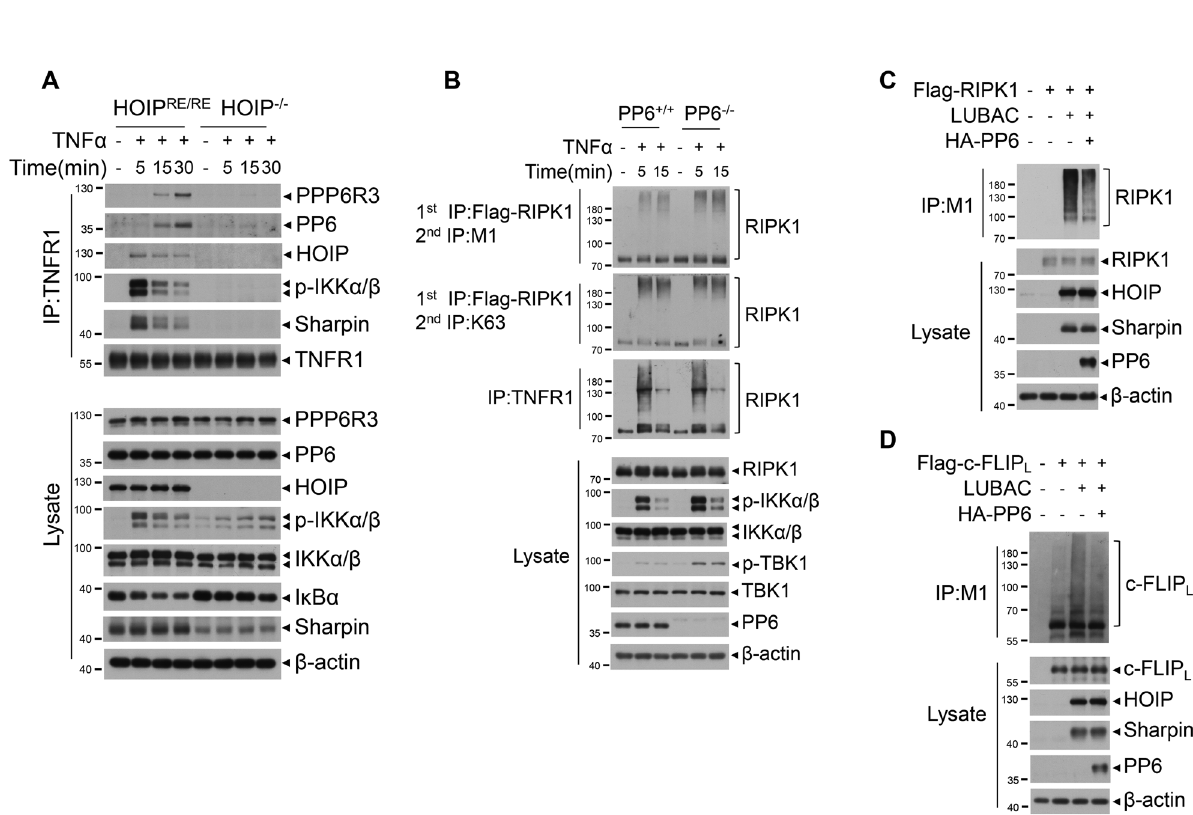
Fig. 6 PP6 negatively modulates LUBAC-mediated M1-ubiquitination of RIPK1 and c-FLIP L . A HOIP − / − or HOIP reconstituted MEFs were treated with TNF α for indicated periods time. Cells were lysed with NP-40 buffer and immunoprecipitated with anti-TNFR1 antibody. The immunocomplexes and whole-cell lysates were analyzed by western blotting with indicated antibodies. B PP6 + / + and PP6 − / − L929 cells with Flag-RIPK1 stable expression were treated with TNF α for indicated periods of time. Cells were lysed with NP-40 buffer and immunoprecipitated with anti-Flag beads. The isolated complex I was eluted with urea lysis buffer. The eluted complex I was further immunoprecipitated with chain speci fi c M1 or K63 ubiquitin antibody. The immunocomplexes and whole-cell lysates were analyzed by western blotting with indicated antibodies. C Flag-RIPK1 was co-expressed with LUBAC (HA-HOIP/Myc-HOIL/Flag-Sharpin) or HA-PP6 in 293T cells for 20 h. Cells were lysed with urea lysis buffer and immunoprecipitated with chain speci fi c M1 ubiquitin antibody. The immunocomplexes and whole-cell lysates were analyzed by western blotting with indicated antibodies. D Flag-tagged c-FLIP L was co- expressed with LUBAC (HA-HOIP/Myc-HOIL/Flag-Sharpin) or HA-PP6 in 293T cells for 20 h. Cells were treated with PS341 8 h after transfection. Cells were lysed with urea lysis buffer and immunoprecipitated with chain speci fi c M1 ubiquitin antibody. The immunocomplexes and whole- cell lysates were analyzed by western blotting with indicated antibodies. Concentrations of reagents used: TNF α (T), 50 ng/ml; PS341, 100 nM.